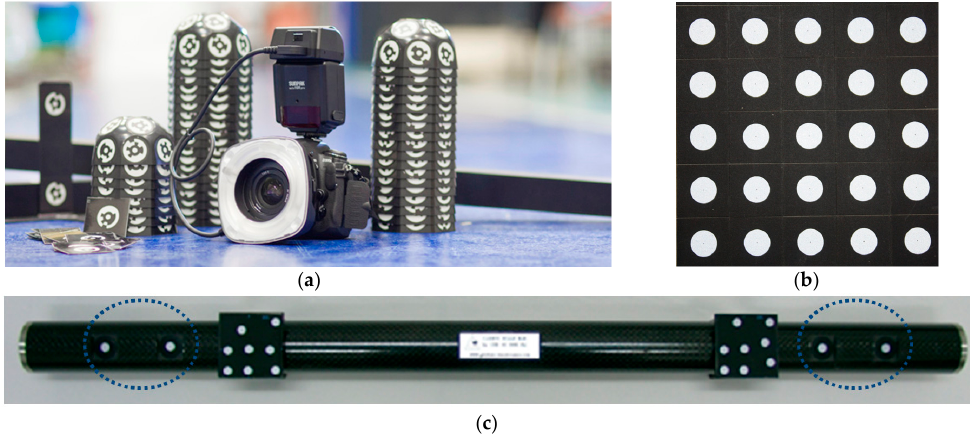
Figure 2. Measuring instrumental in portable photogrammetry ( a ), including a fixed focal consumer grade digital camera (Nikon D300S, 4288 × 2848 pixels, 24 mm), measuring frame, and multicoded target artifacts for efficient image matching assistance; ( b ) non-coded targets (Geodesie, diameter 8 mm) [22] for raw part measurement; and ( c ) carbon-fiber scale (Geodesie) [22] for precise traceability and precision evaluation, with precalibrated distances between non-coded targets (blue).